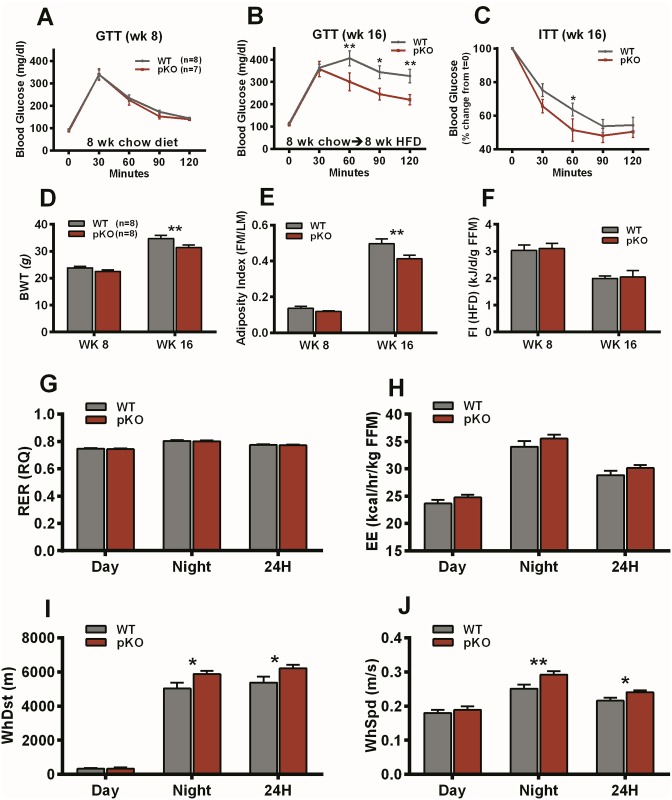
Diabetic and metabolic measurements of mice with inactivated Mest.(A) Data shows glucose tolerance test (GTT) of WT (n = 8) and MestpKO (pKO) mice (n = 7) fed a chow diet at 8 weeks of age. (B) GTT and (C) insulin tolerance test (ITT) of WT (n = 8) and pKO (n = 7) at 16 weeks of age after feeding mice a high fat diet (HFD) for 8 weeks. (D) Bodyweight (BWT), (E) adiposity index (fat mass/lean mass; FM/LM) and (F) food intake (FI; kJ/day normalized to fat-free mass (FFM) are presented for an additional cohort of WT (n = 8) and pKO (n = 8) mice fed a HFD from 8 to 16 weeks of age that were subjected to indirect calorimetric analyses. Body composition measurements were performed via DEXA. Indirect calorimetric measurements of (G) respiratory quotient (RQ), (H) energy expenditure (EE), (I) wheel running distance (WhDst) and (J) wheel speed (WhSpd) were performed on mice for 1 week after being fed a HFD for 8 weeks. All data is presented as the mean ± SEM. Significance between groups was determined using two-tailed unpaired parametric t-tests and 1 or 2 asterisks indicate significant P-values of ≤0.05 and ≤0.01 respectively.